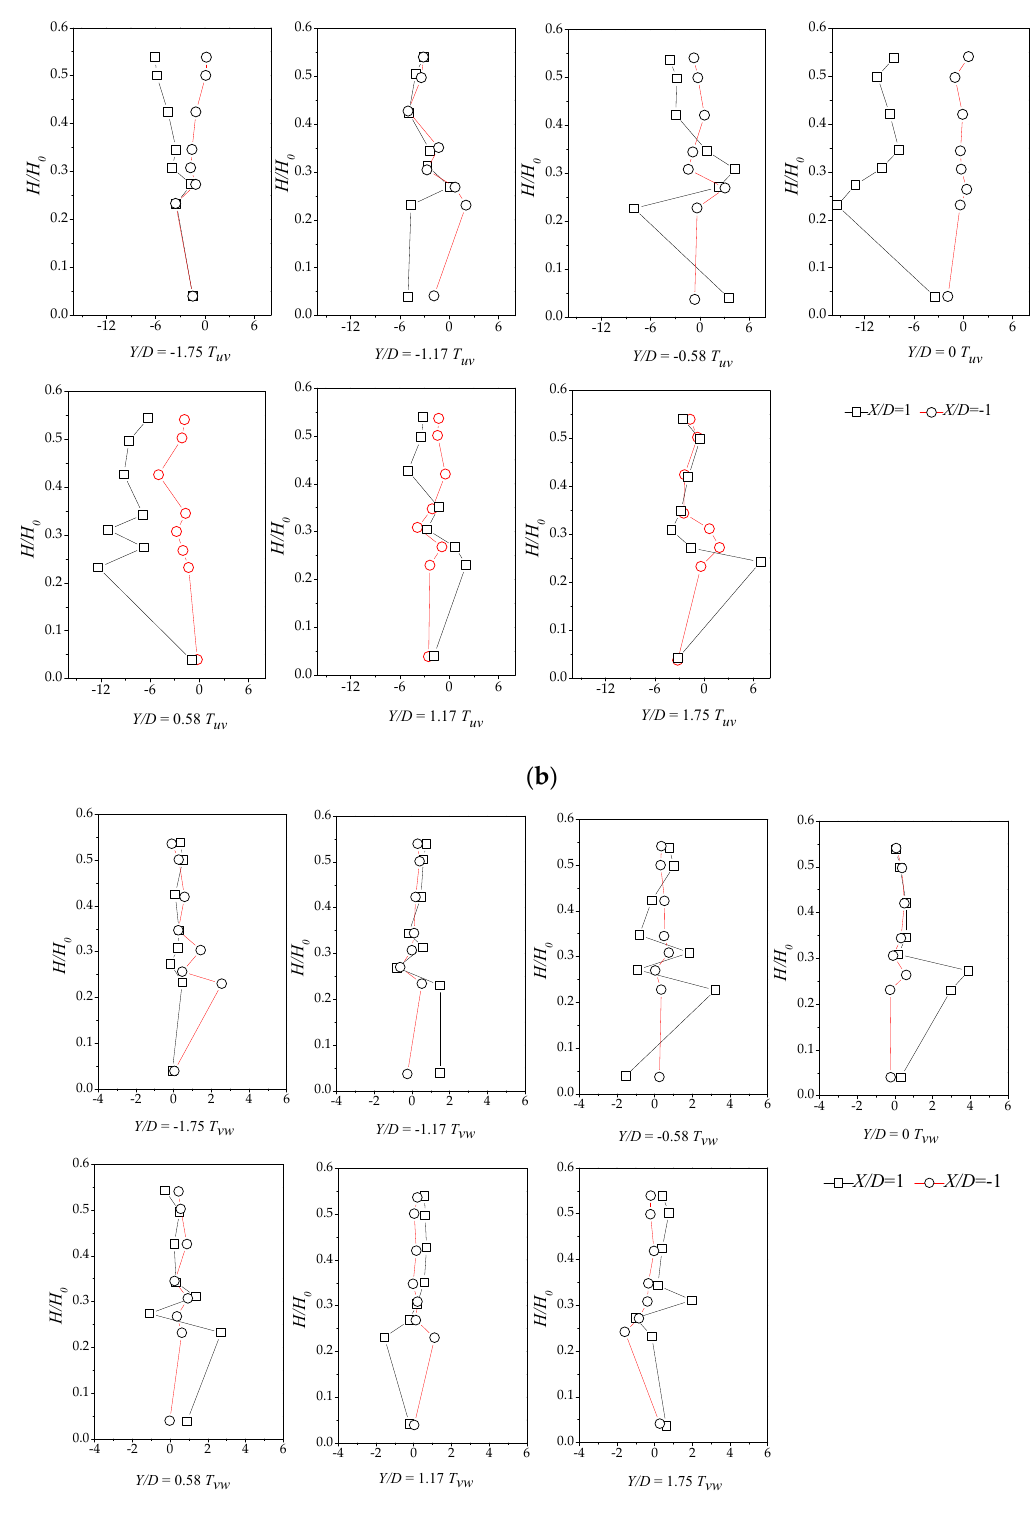
Figure 8. Comparison of lateral stream-wise shear stress distributions on sections at X / D = ± 1. ( a ) T uw , ( b ) T uv , and ( c ) T vw .